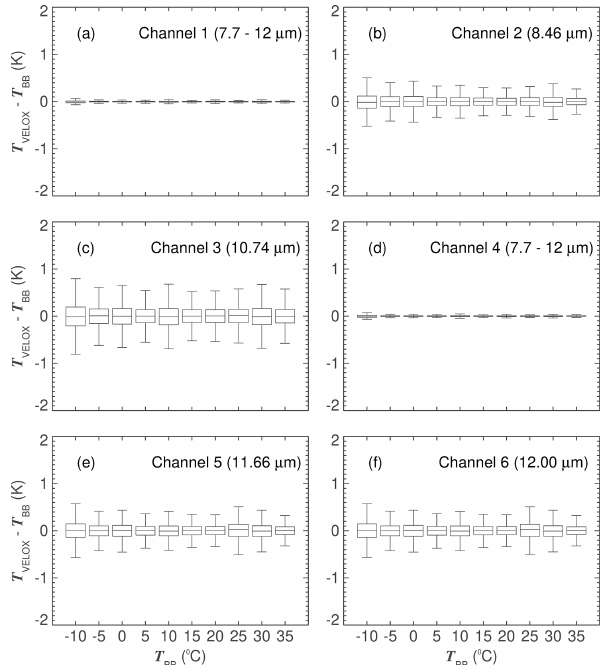
Figure 5. Box-and-whisker plots for each of the six channels of the TIR imager. Each panel, (a) to (f) , shows the deviations of the measured brightness temperature ( T VELOX ) of the single channels from the different black body temperature settings ( T BB ). The box encloses the interquartile range, defined at the 25th and 75th per- centiles. The whiskers extend out to 1.5 times on either side of the 25th and 75th